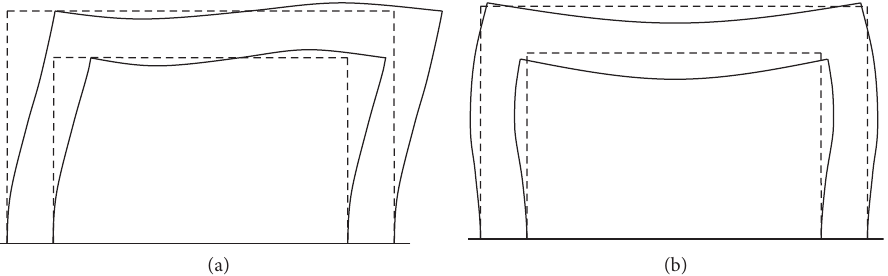
Figure 1: (a) Lateral sway and (b) floor vibration mode shapes of a plane portal frame.